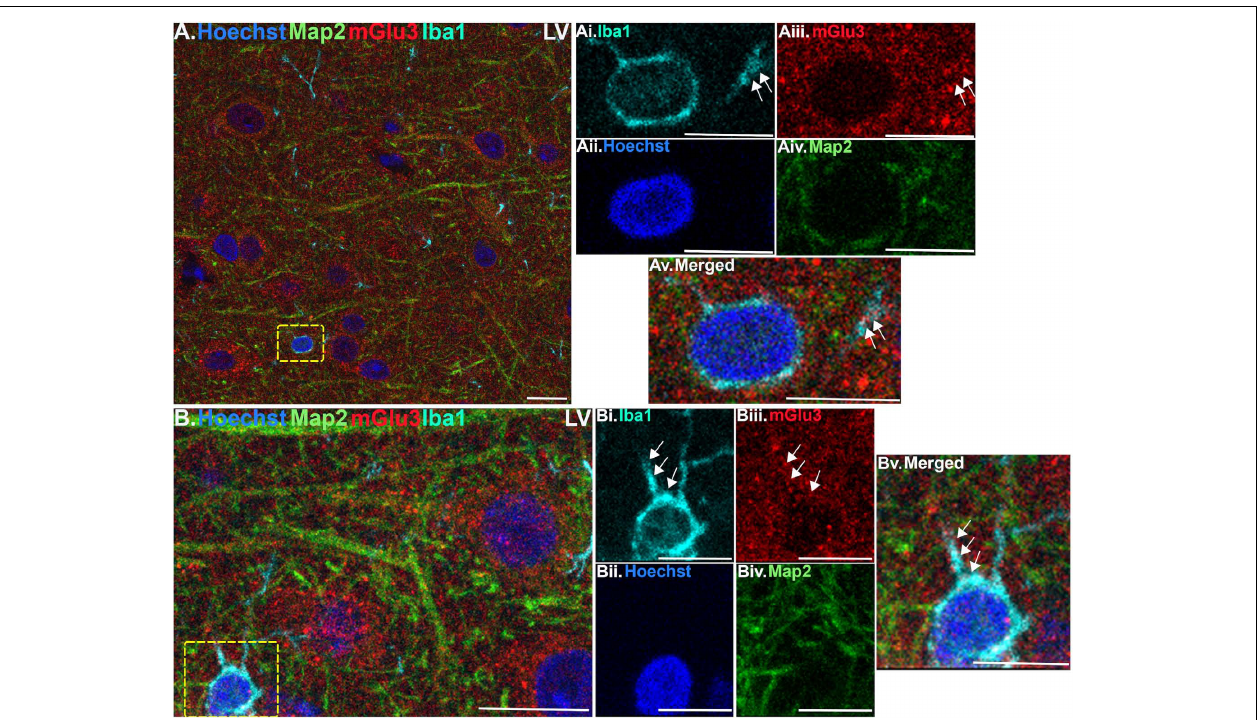
FIGURE 6 | Multiple label immunofluorescence of mGlu3 labeling in microglia in layer V of rat PL mPFC. Tissue was labeled with antibodies recognizing the microglial protein Iba1 (cyan), mGlu3 (red), the dendritic marker Map2 (green), as well as the nuclear Hoechst stain (blue). (A) Similarly, to layer II/III, there are diffuse Iba1 positive microglial processes throughout the neuropil in layer V. (Ai–v) Magnified area of the yellow box in (A) , showing an Iba1 positive microglial soma surrounding the Hoechst positive nucleus (blue) and emanating processes (cyan). The process contains mGlu3 (red) indicated by white arrows, which are Map2 negative. (B) In another region of layer V, there is an Iba1 positive microglial soma (cyan) with two visible processes in this plane. (Bi–v) Magnified area of the yellow box in (B) , demonstrates mGlu3 localization within the processes extending from the soma, as demarcated by the white arrows. Scale bars, 10 µ m (A,B) ; 5 µ m (Ai–v,Bi–v)